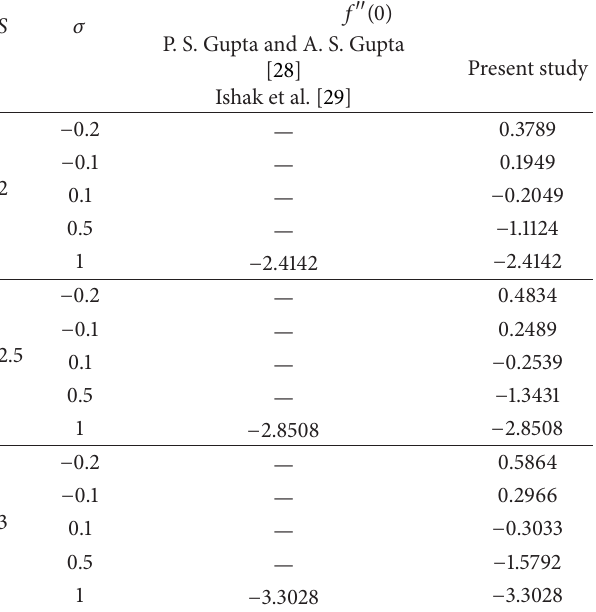
Table 1: Values of 𝑓 󸀠󸀠 (0) for different values of 𝑆